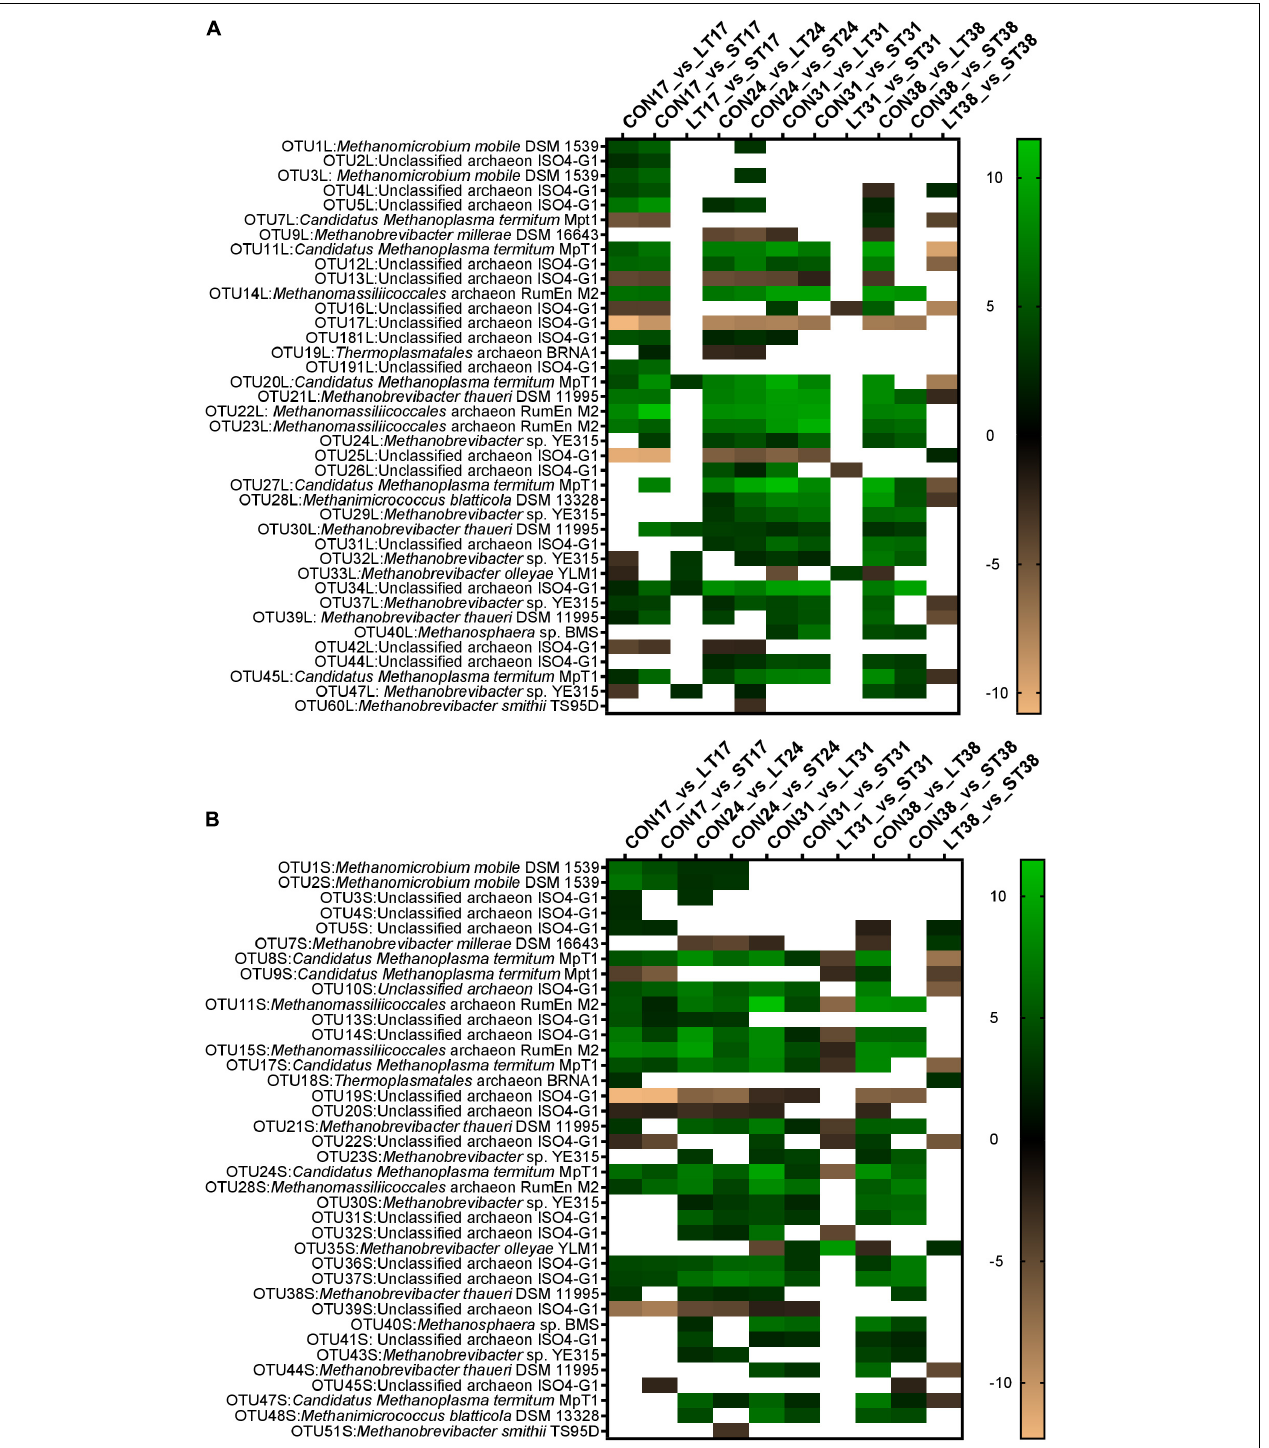
FIGURE 5 | Heatmaps of significantly differentially abundant ( P < 0.05, differential OTU analysis, DESeq2) archaeal operational taxonomic units (OTUs) in liquid-associated (A) and solid-associated (B) microbiota based on log2fold changes, which is indicated by the brown to green color scale. A threshold of ± 2 was applied, and white indicate no significant differences. The heatmap displays the significant differences at days 17, 24, 31, and 38 between the three treatment groups (CON, LT, and ST). No significant differences were detected at day 10 and at day 24 between LT and ST group.